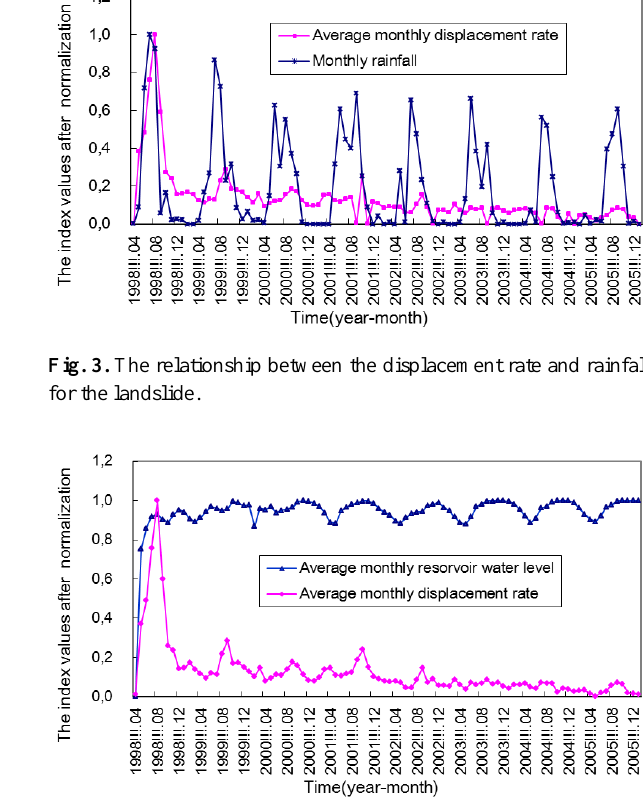
Fig. 4. The relationship between the displacement rate and reservoir water level for the landslide.